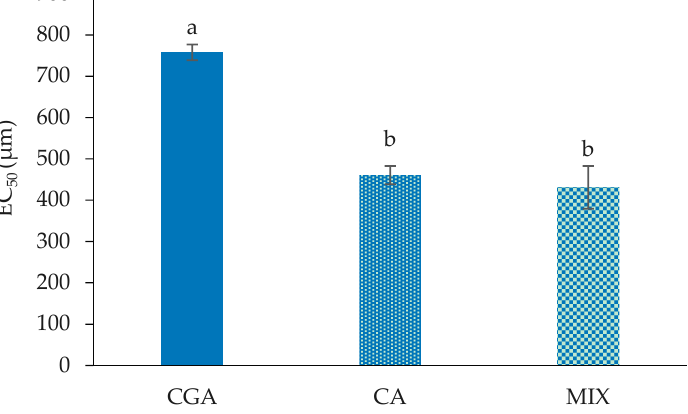
Figure 2. The concentrations of CGA, CA and MIX that decrease cell viability by 50% (EC 50 ). Data are represented as mean ± SE. Statistical analysis was performed via one-way ANOVA. Bars not sharing the same letters are significantly different ( p < 0.05) from each other. CGA = chlorogenic acid; CA = caffeic acid; MIX = equimolar mixture of the four tested compounds.